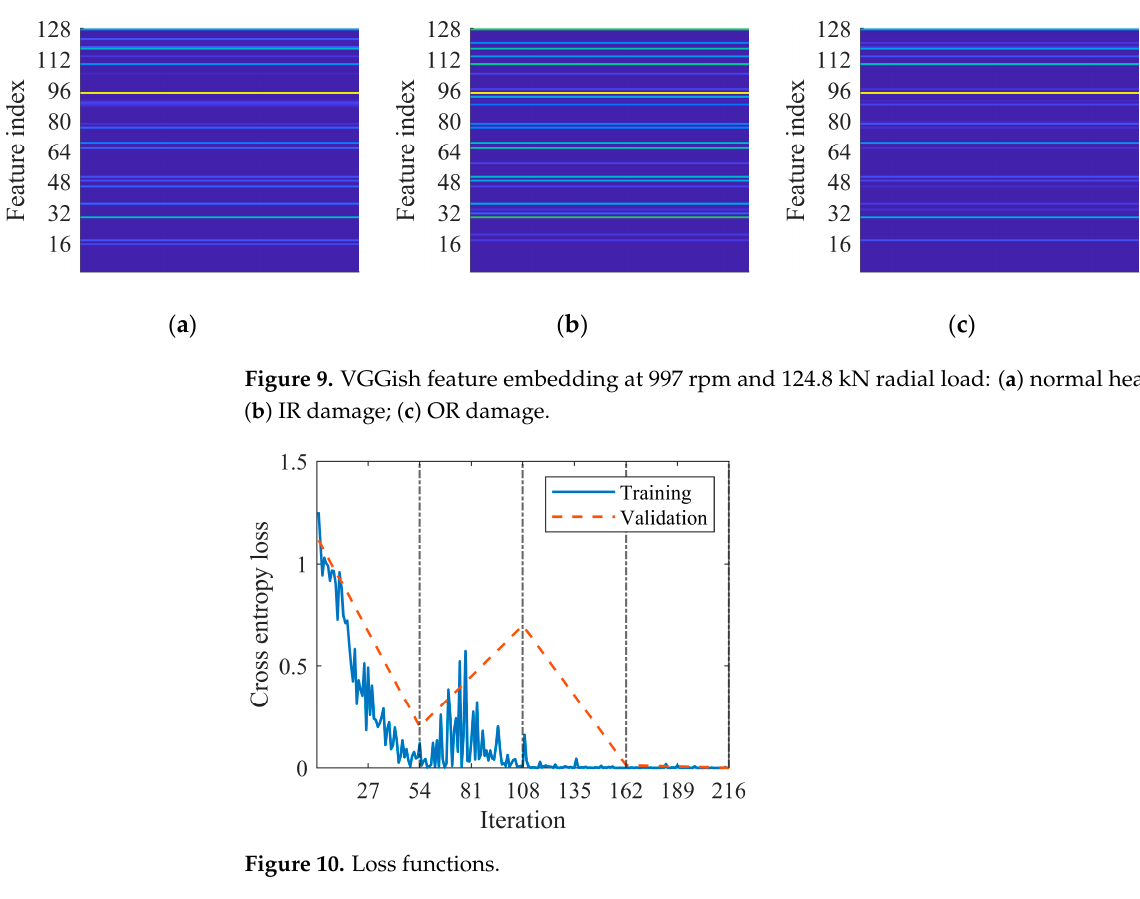
Figure 8. Mel spectrogram at 997 rpm and 124.8 kN radial load: ( a ) normal health state; ( b ) IR dam- age; ( c ) OR damage.